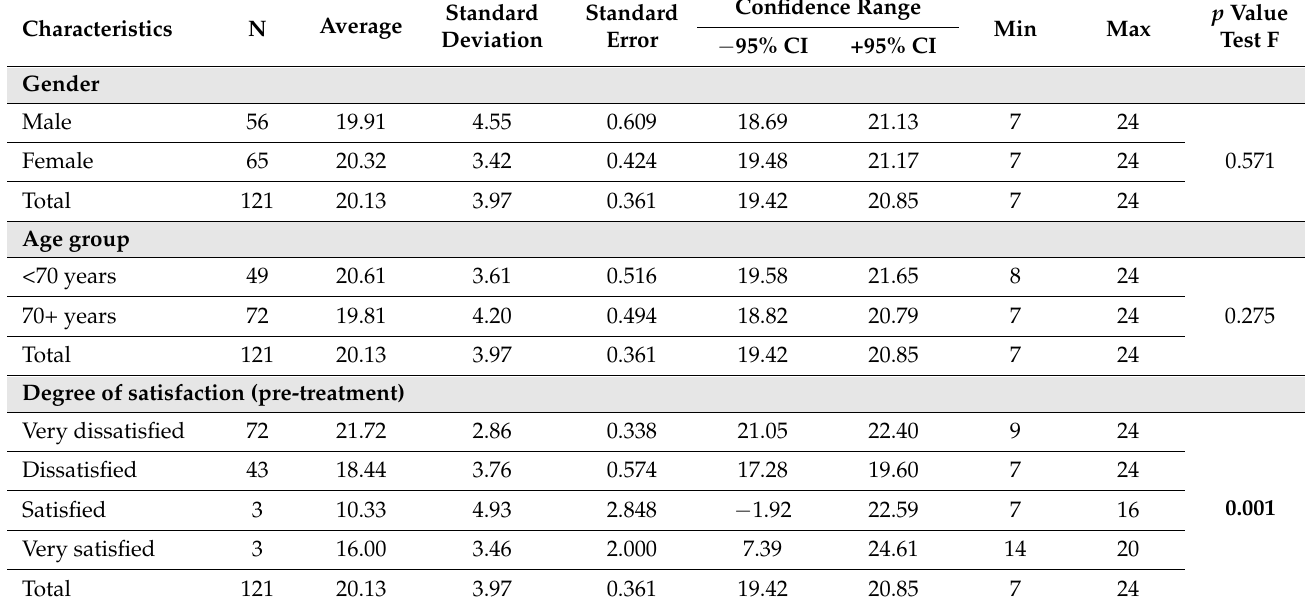
Table 10. Statistical indicators of the vision difficulty assessment score.